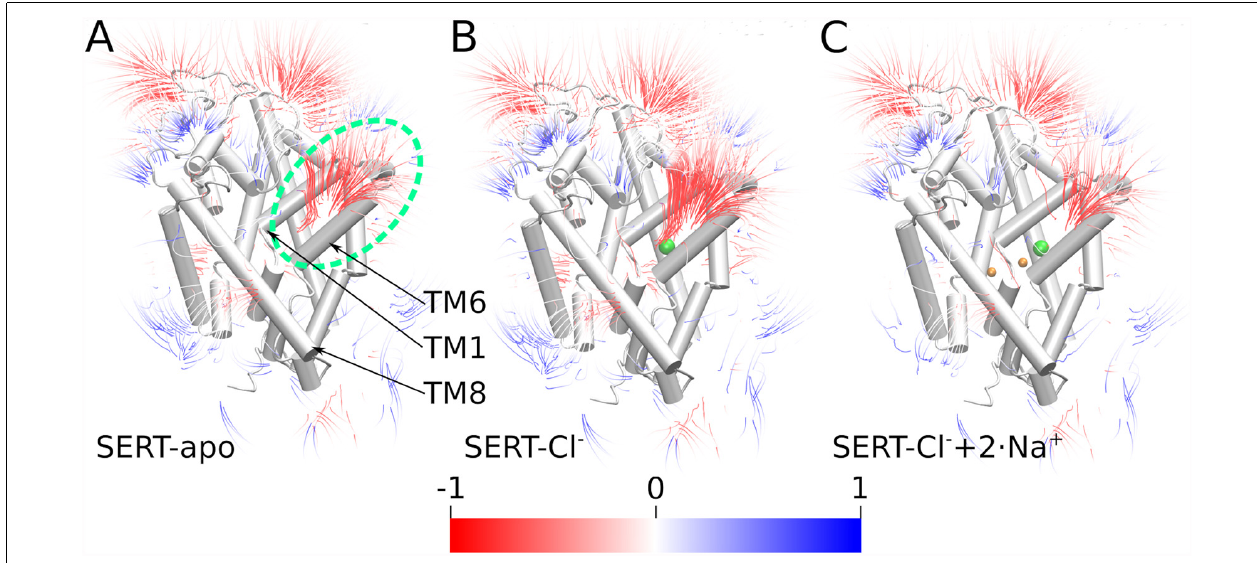
FIGURE 5 | Electrostatic gradients and fields. Electrostatic potential field lines solved by the adaptive Poisson-Boltzmann solver (APBS) of the outward-open SERT of (A) the apo state, (B) SERT with bound Cl − , (C) SERT with bound Cl − and Na + ions; the green dashed ellipse highlights the outer vestibule. Field lines are colored by potential with a color gradient form red through white till blue representing a scale from − 1 to 1 (kT/e). Field strength more negative than − 1 is red while values above 1 are